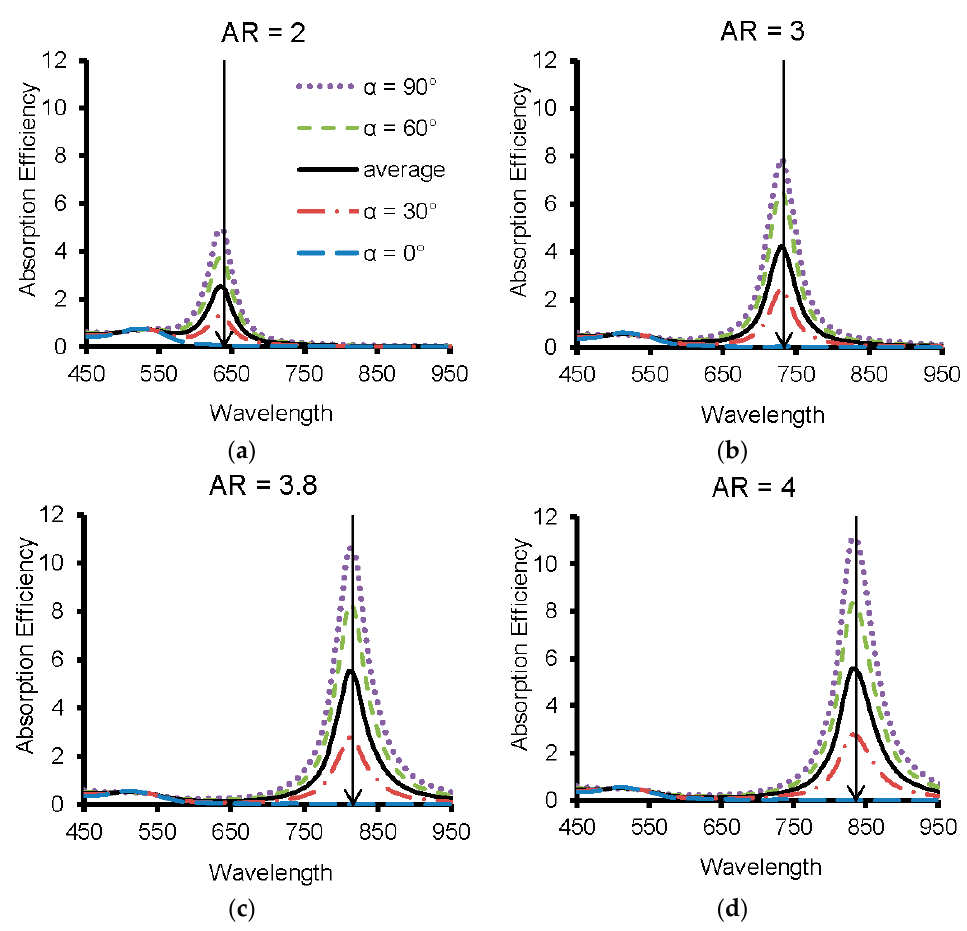
Figure 7. Spectral dependency of absorption efficiency of a single GNR with different aspect ratios (AR), ( a ) AR = 2, ( b ) AR = 3, ( c ) AR = 3.8 and ( d ) AR = 4.